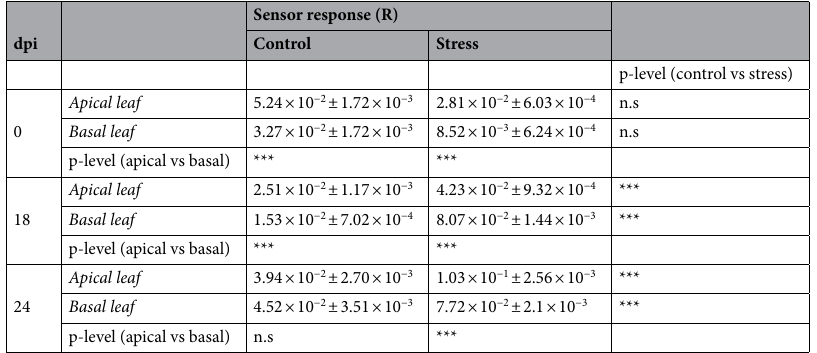
Table 1. Sensor Response (R) of control and salt stressed A. donax plants measured at different times: before the beginning of the experiment (0 dpi), in the initial phase (18 dpi), and in the median phase (24 dpi). Values represent the mean of the daily R value ± standard errors (n = 3). ANOVA has been used to assess statistical differences between leaves of control and salt-stressed plants (*** p ≤ 0.001; ** p ≤ 0.01; * p ≤ 0.05).